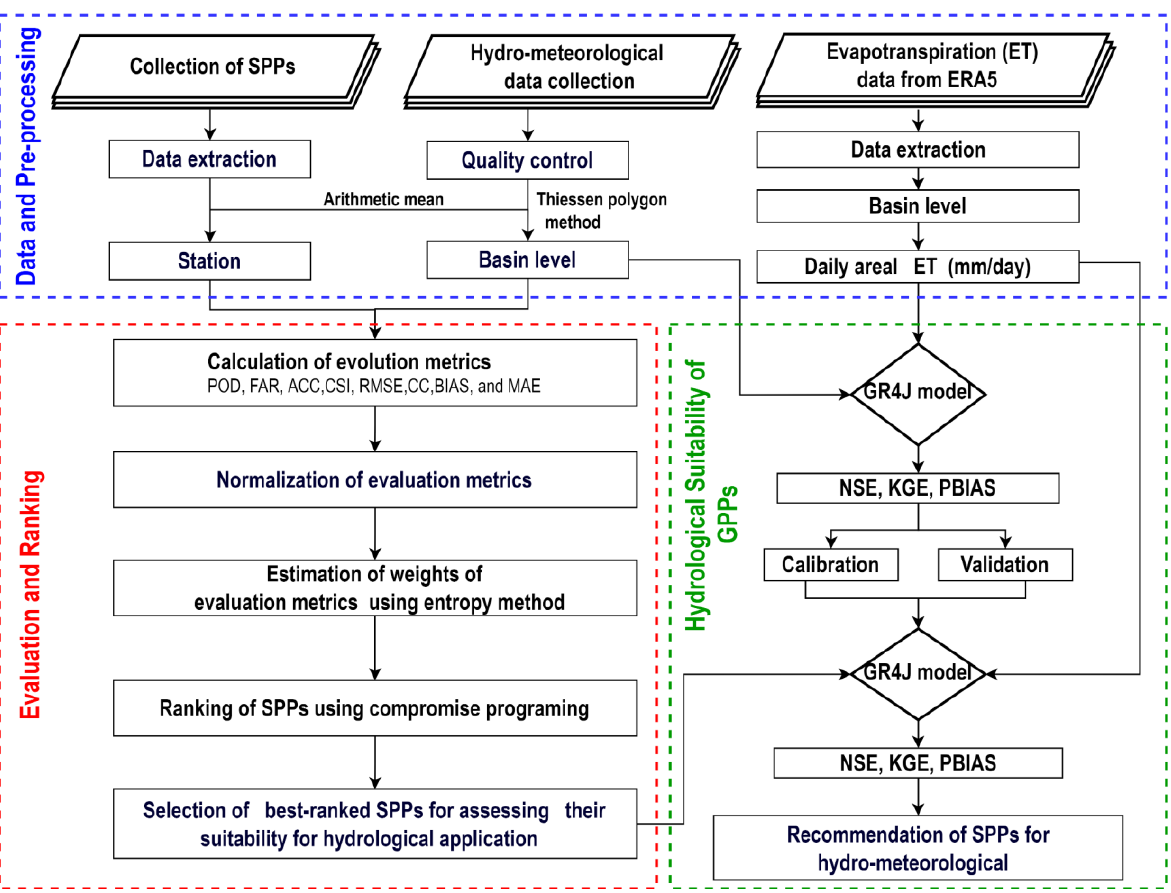
Figure 1. An overall developed methodological framework which comprehensively evaluates and ranks the SPPs and assesses their hydrological utility.